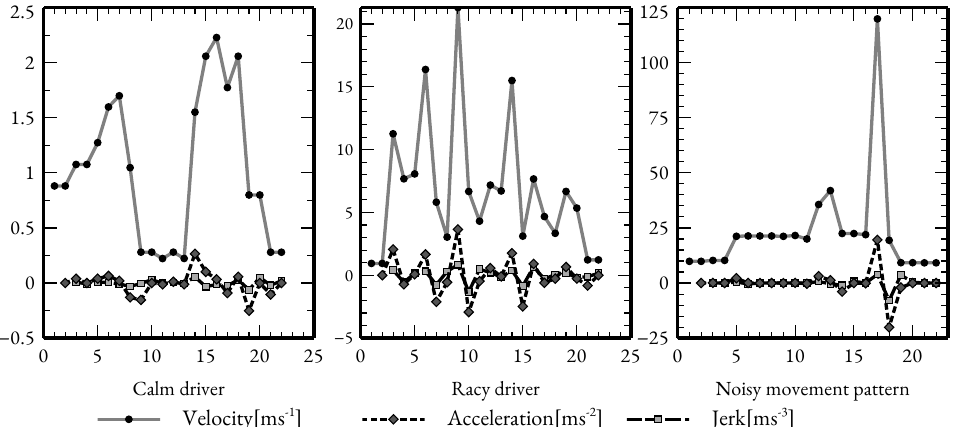
Figure 1. Velocity, acceleration, and jerk patterns corresponding to a calm and a racy driver in contrast to the same quantities of a movement pattern containing noisy GPS logs. Note that the y -axis in each plot has a completely different range. Either the acceleration or the jerk pattern could efficiently distinguish the calm driver from the racy driver. In case of the noisy movement pattern, either the acceleration or the jerk pattern could efficiently reveal the existence of a noisy GPS log. Our proposed exponentially based feature ω , cf. (7), shows high robustness with regard to noise. This helps to entirely accommodate noisy movement patterns in a separate